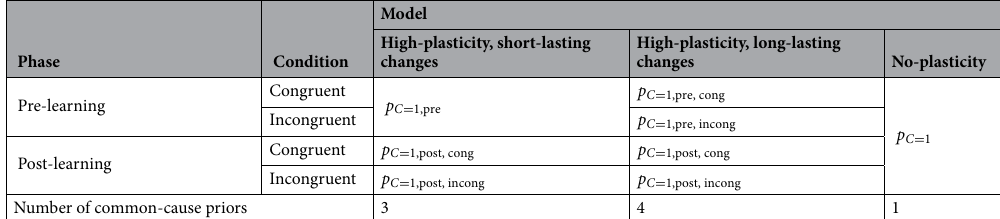
Table 1. Common-cause priors in the three tested models.